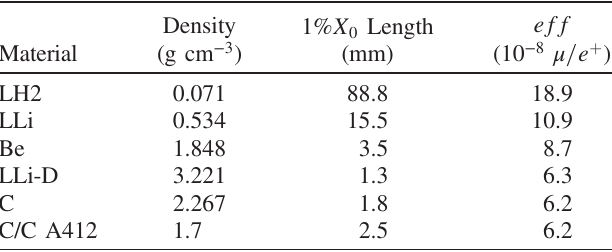
TABLE V. Muon production efficiency from a positron beam at 45 GeV interacting with beryllium, liquid hydrogen (LH2), liquid lithium (LLi), a composition of 10% liquid lithium and 90% diamond powder (LLi-D), carbon, and a carbon composite (C/C A412). Density and length for 1% X 0 are